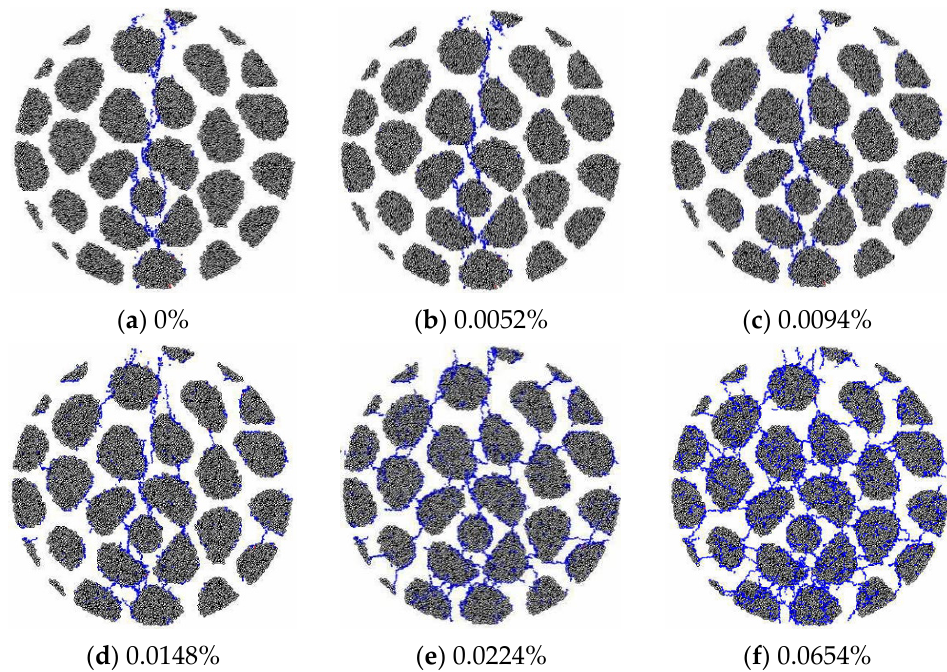
Figure 9. Microcrack morphology in the failure state of the specimen GC20-5%. The microcrack morphology in the tensile failure state of specimen RC20 with different expansions is shown in Figure 10. It is compared with that of GC20-5%. The same tendency of microcrack distribution reveals that the variation in gel proportion affects the splitting failure mode.